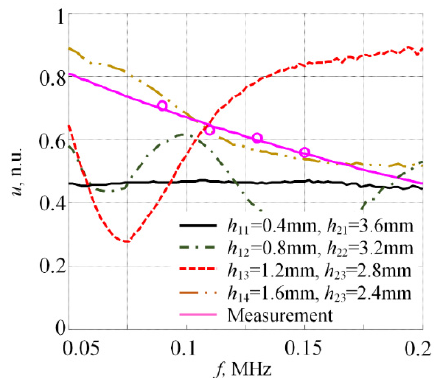
Figure 15. Sketch of 3D GFRP numerical model which was used for the verification of the damage size and the depth estimation technique.